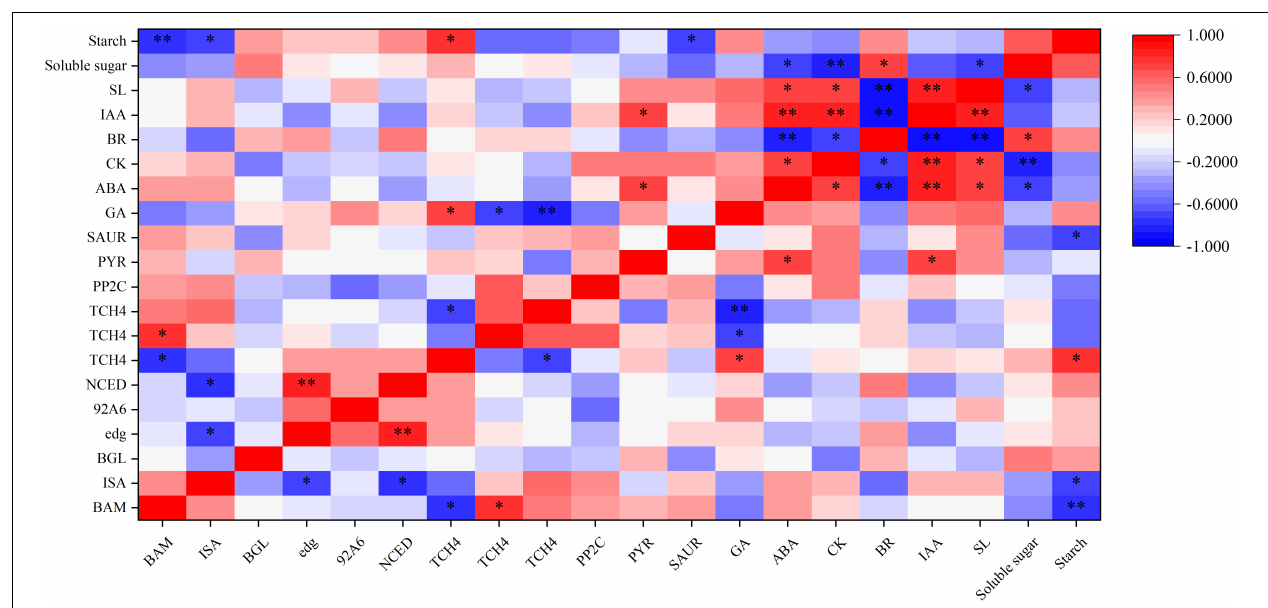
FIGURE 10 | Spearman’s correlation coefficient between the starch and sucrose metabolism and hormone synthesis and signaling pathway in bulbil of P. ternata under BR and Pcz treatments. ∗ and ∗∗ indicated the significant correlations at the 0.05 and 0.01 level,